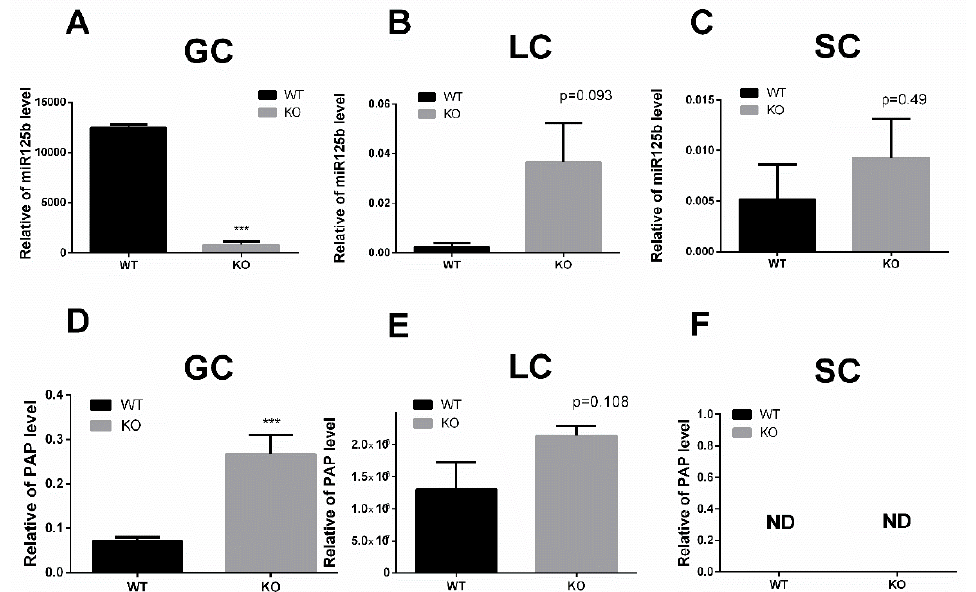
Figure 6. The Relative Expression of miR-125b-2 and PAP mRNA in Leydig cells (LC), Sertoli cells (SC), and germ cells (GC). ( A ) The relative level of miR-125b in GC. ( B ) The relative level of miR-125b in LC. ( C ) The relative level of miR-125b in SC. ( D ) The relative of mRNA level PAP in GC. ( E ) The relative mRNA level of PAP in LC. ( F ) The relative mRNA level of PAP in SC ( n = 5). ND—not detected. Values are the mean ± SEM. *** p < 0.001.